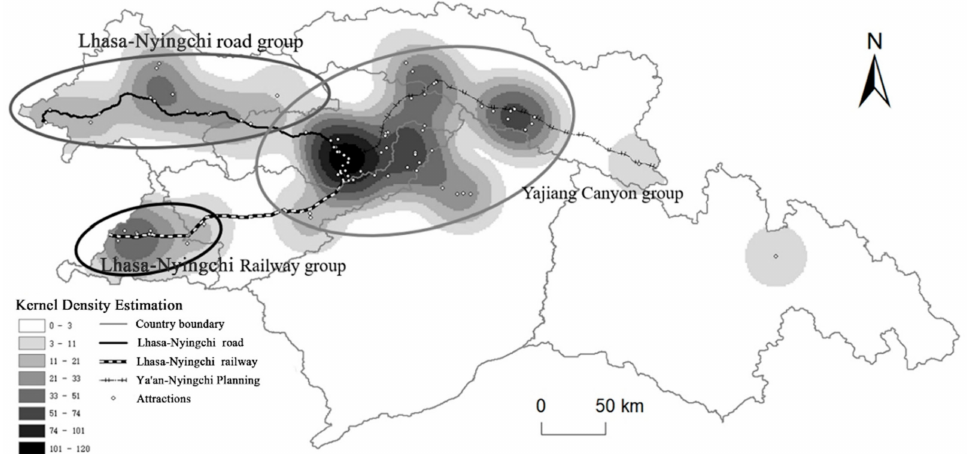
Figure 9. Tourism group classification based on spatial location and traffic accessibility of tourist attractions. Note: The map is based on the standard map of the Map Technical Review Centre of the Ministry of Natural Resources of China (Number: GS (2019)4342), with no modifications to the base map. Map-making by the